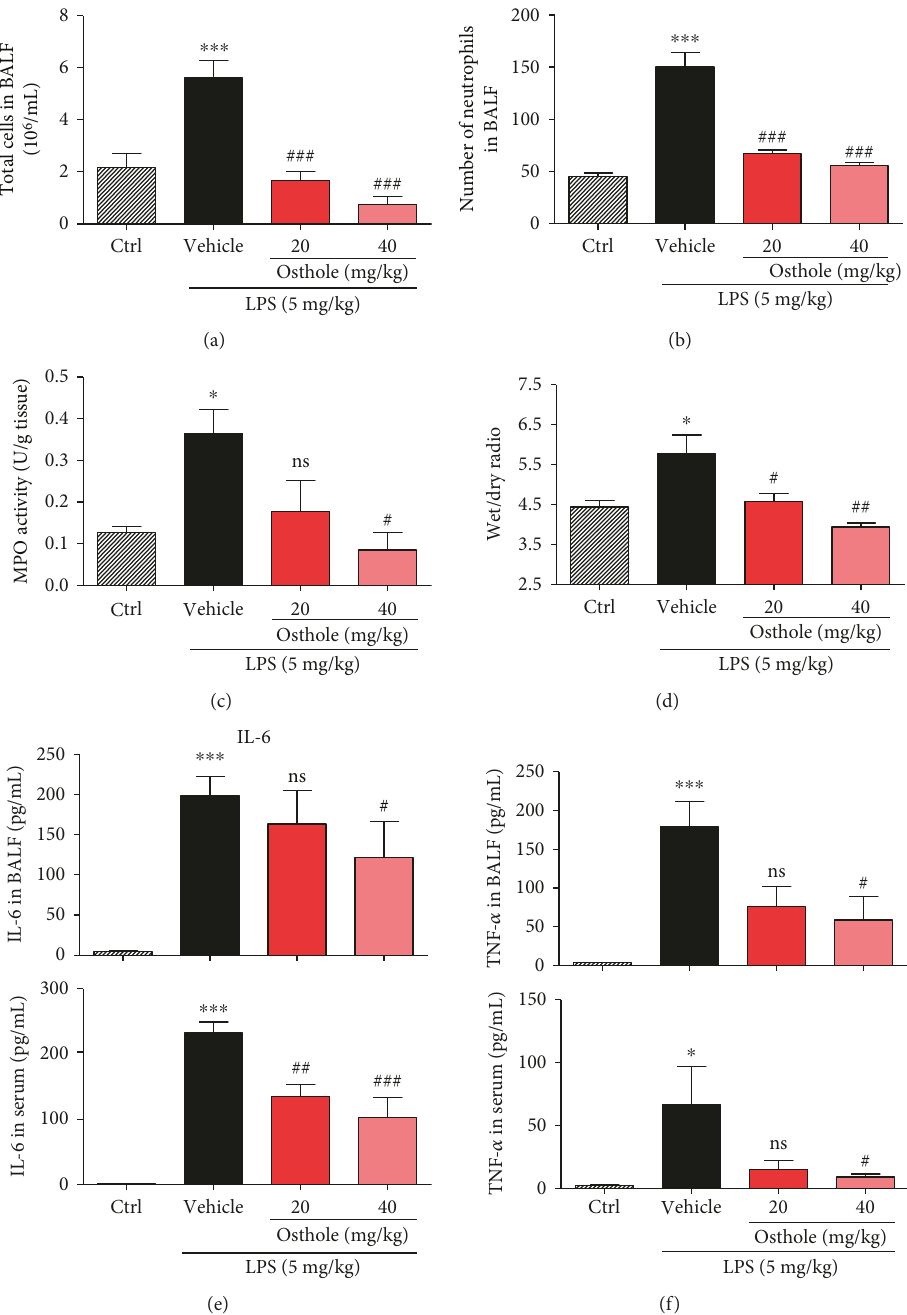
Figure 5: Osthole inhibits in fl ammatory cell in fi ltration and cytokine secretion in ALI. ALI was induced as described (Materials and Methods). Brie fl y, C57BL/6 mice were pretreated for 30 min with 20mg/kg or 40mg/kg osthole via ip injection, followed by intratracheal injection of 5 mg/kg LPS, and lungs were sampled 6h later for analyses. (a) Number of total cells and (b) neutrophils in BALF was determined by counting microscopic fi elds; n = 7 . (c) Lung tissue myeloperoxidase (MPO) activity assay was determined as an index of neutrophil activity; values are reported as mean ± SEM in U/g tissue; n = 7 . (d) Wet and dry weights of lung tissue were measured and reported as the ratio of wet to dry as index of pulmonary edema; values are reported as mean ± SEM ; n = 7 . ELISA detection of (e) IL-6 and (f) TNF- α in BALF (upper graph) and serum (lower graph) from the experimental mice was determined, and values are reported as mean ± SEM ; n = 7 . ns=not signi fi cant; ∗ p < 0 05 and ∗∗∗ p < 0 001 , versus control (Ctrl). # p < 0 05 , ## p < 0 01 , and ### p < 0 001 , versus